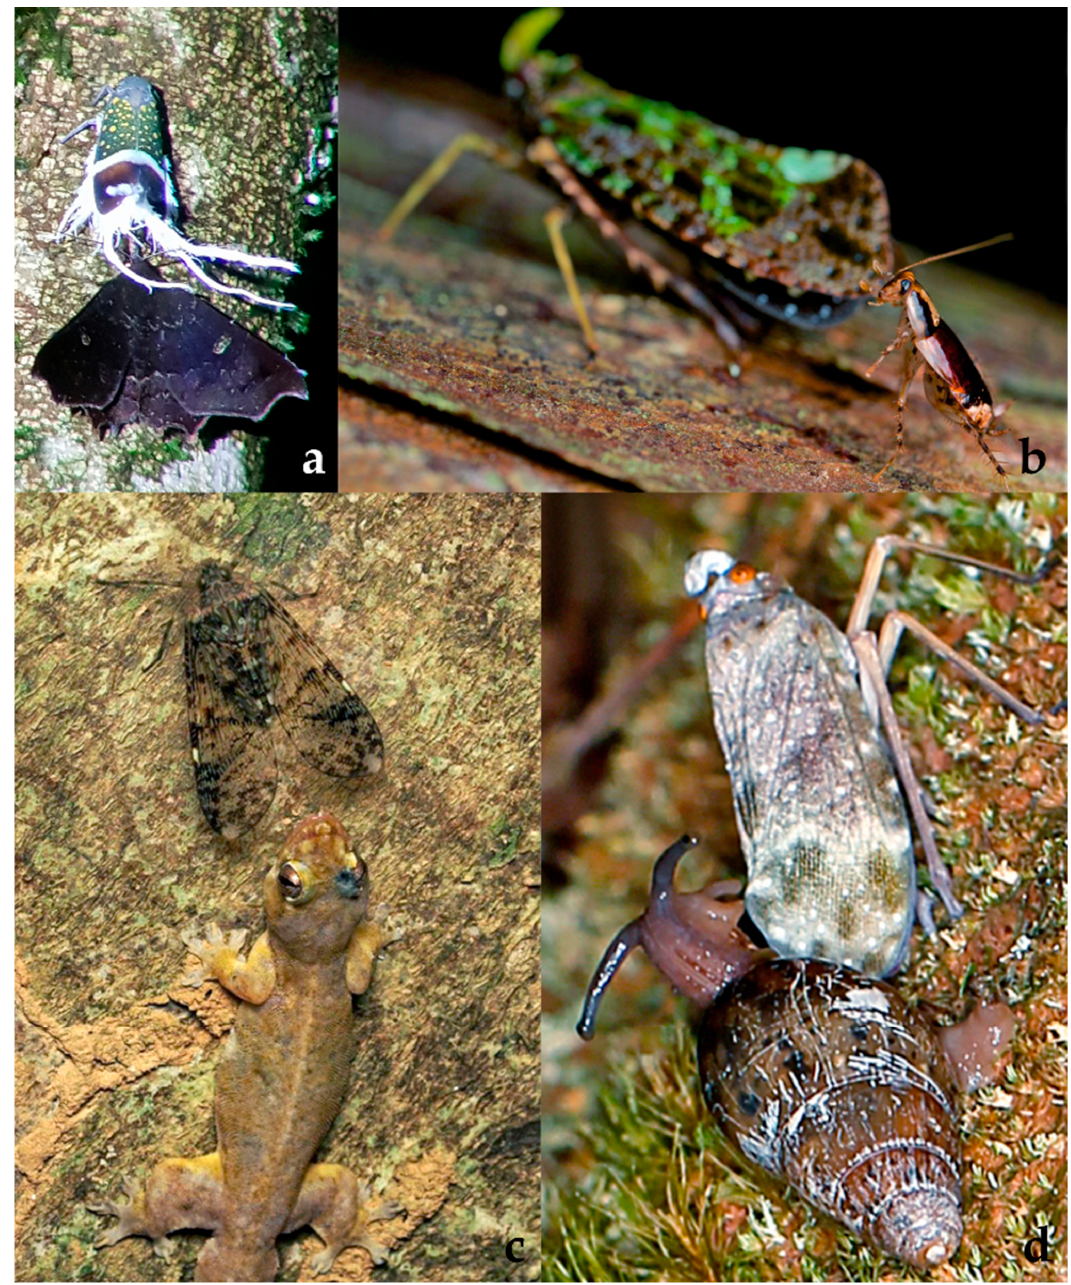
Figure 8. Fulgoridae: ( a ) Alaruasa aerata (Distant, 1887) tended by Lepidoptera: Erebidae: Euclystis sp., Costa Rica: Wildlife Refuge Monteverde, 10°19 ′ N 84°49 ′ W, 25.08.2019, adult on tree trunk, obs. J. Carlos; ( b ) Belbina recurva Lallemand, 1950 tended by Blattodea indet., Madagascar: Andasibe Na- tional Park, 14°28 ′ 28 ″ N 108°32 ′ 27 ″ E, 13.02.2015, adult on tree trunk, obs. P. Bertner; ( c ) Dichoptera sp. tended by Reptilia: Squamata: Gekkonidae indet., Thailand: Phanom Bencha National Park, 8°14 ′ 31 ″ N 98°54 ′ 55 ″ E, 13.12.2019, adult on tree trunk, obs. C. Hübner; ( d ) Enchophora sanguinea Distant, 1887 tended by Gastropoda indet., Costa Rica: La Selva Biological Station, 10°25 ′ 40.6 ″ N 84°00 ′ 22.1 ″ W, 03.02.2016, adult, obs. G. Kunz.